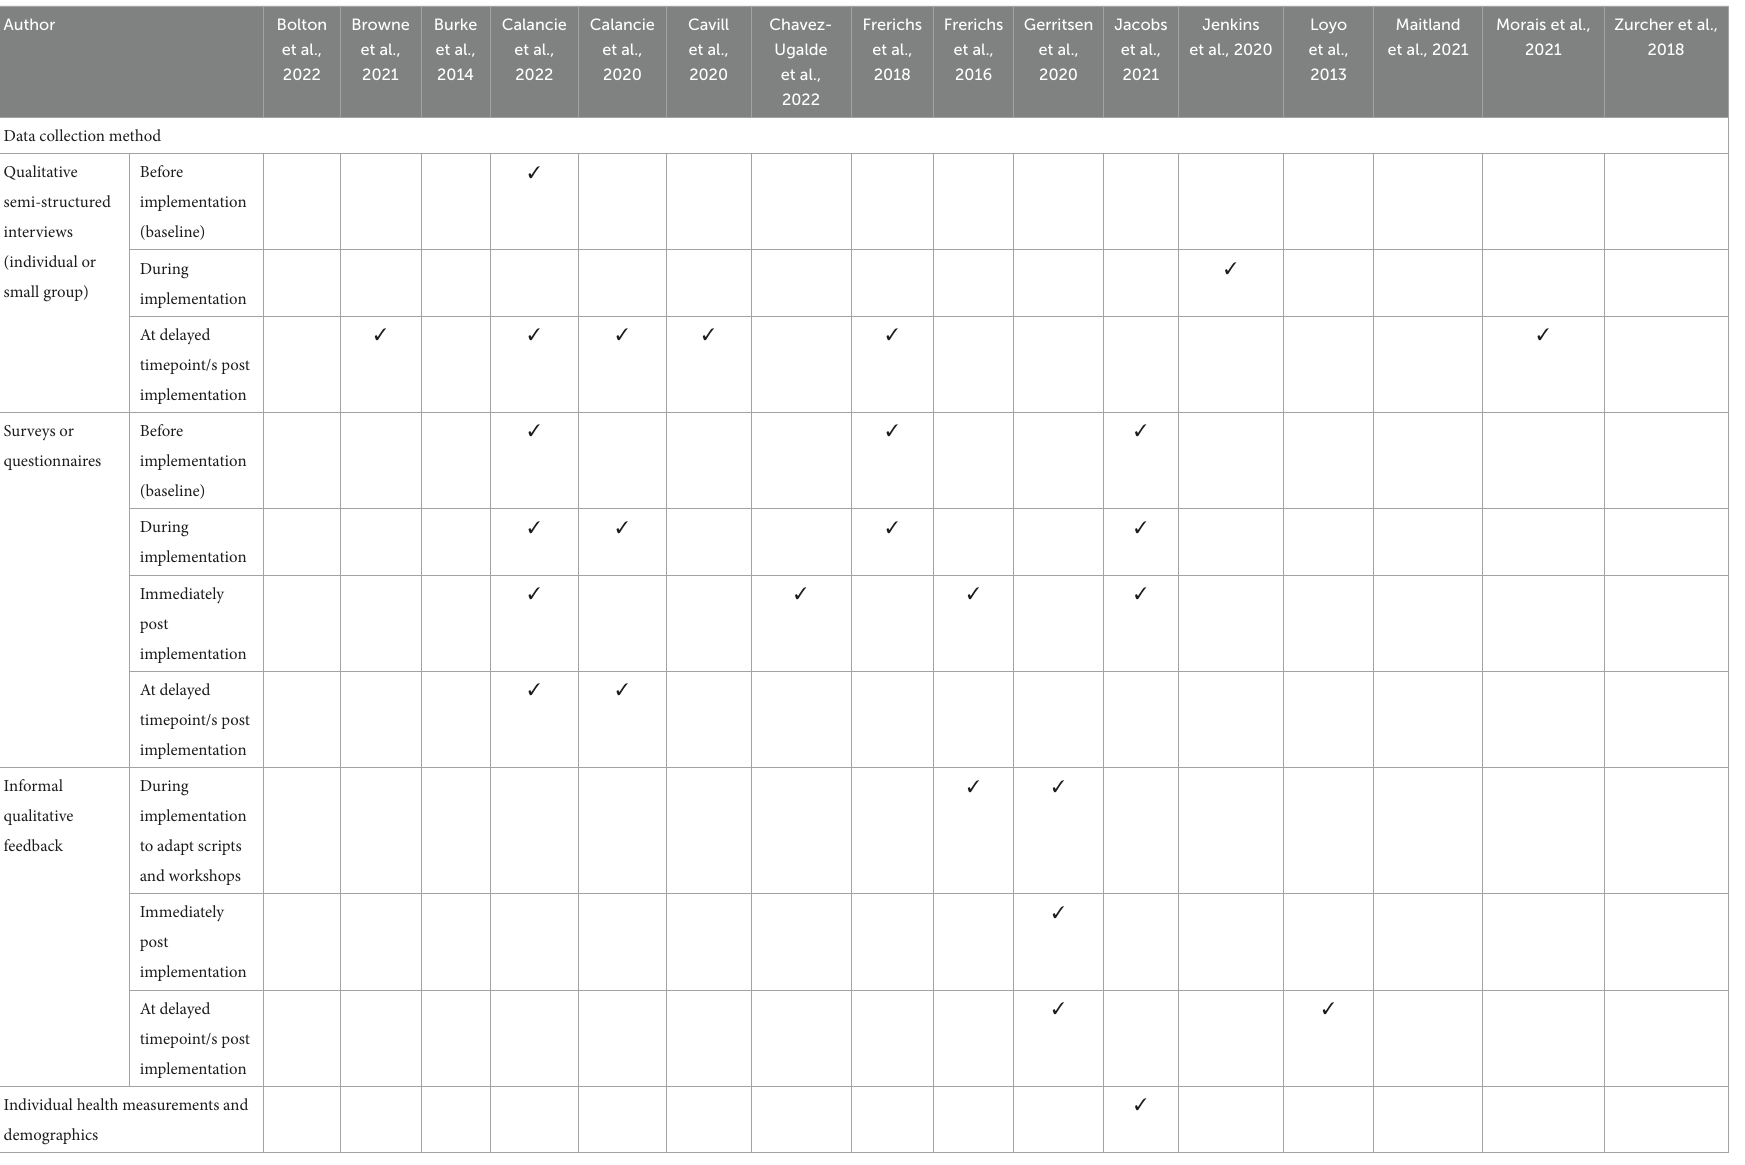
TABLE 5 Evaluation method by author for 16 articles that measure